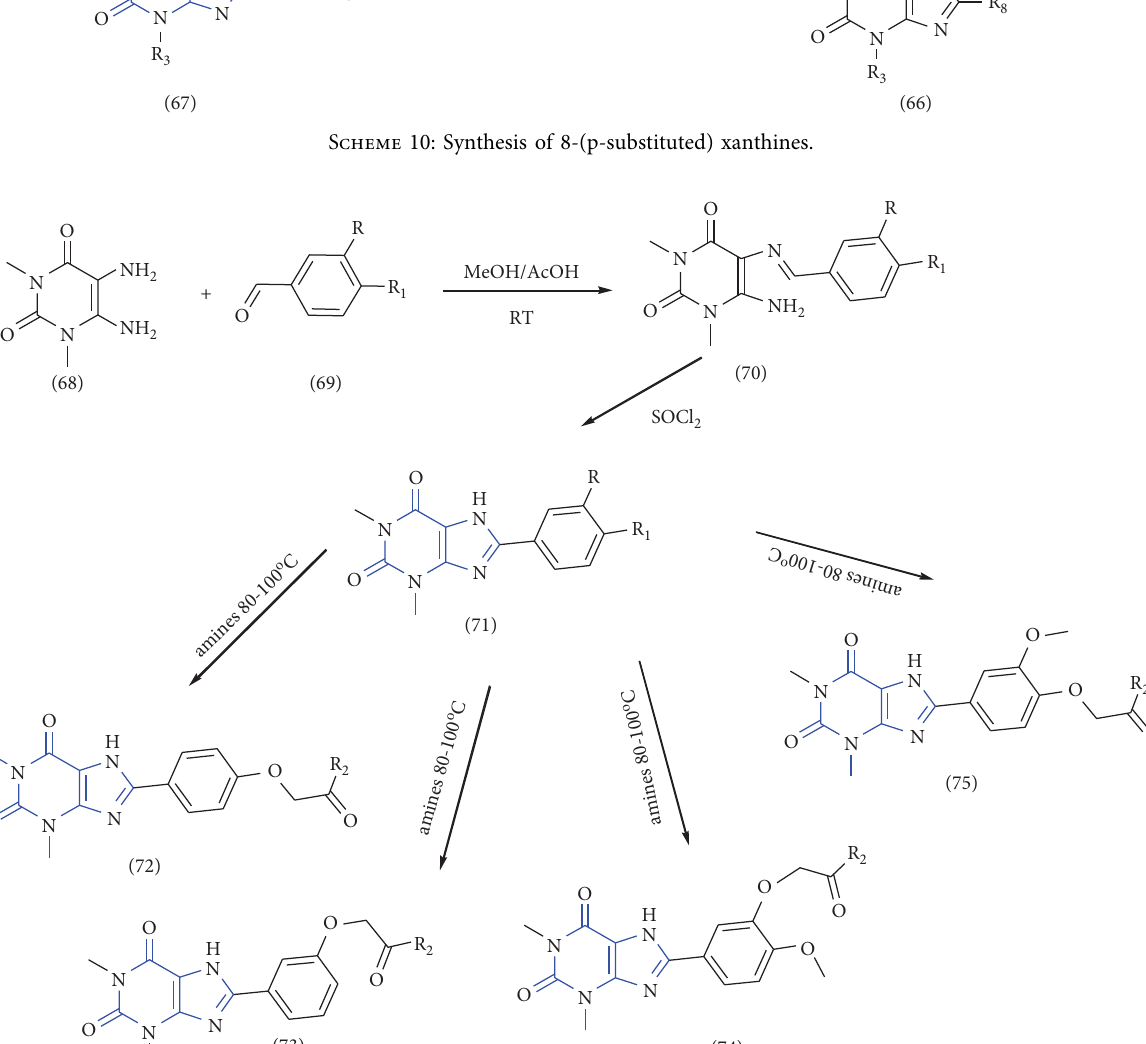
Scheme 11: Systematic study for the synthesis of xanthine carboxylate